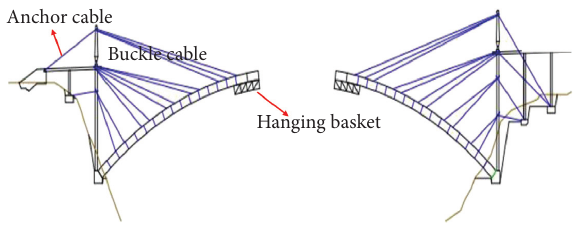
Figure 3: Cantilever pouring